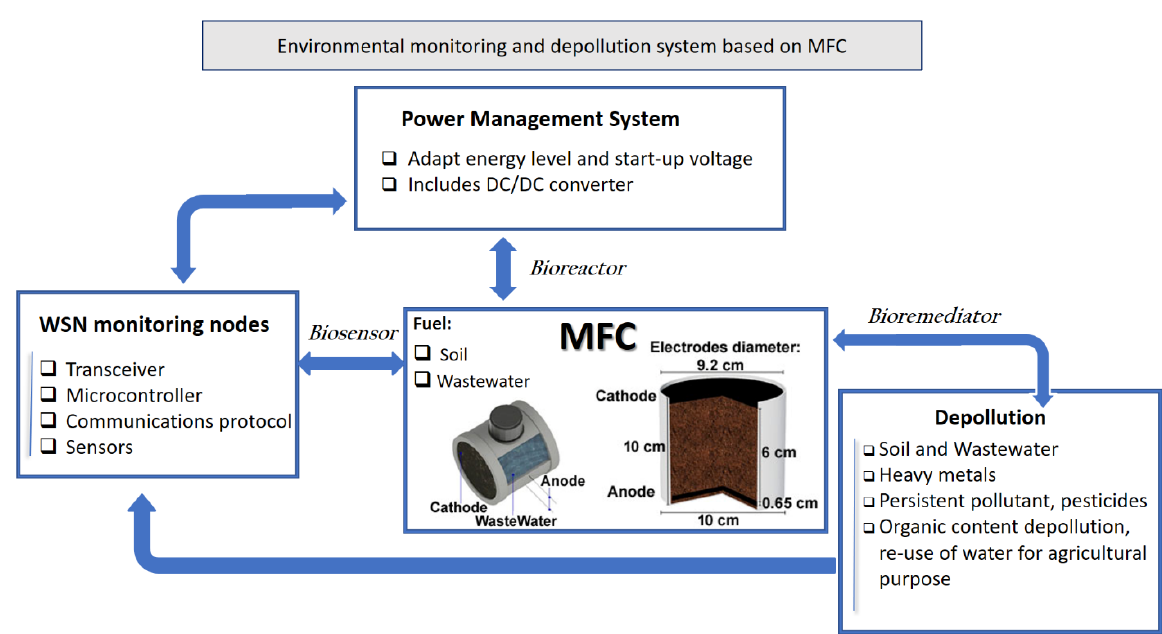
Figure 3. Environmental monitoring system based on a wireless sensor network (WSN) and MFC.